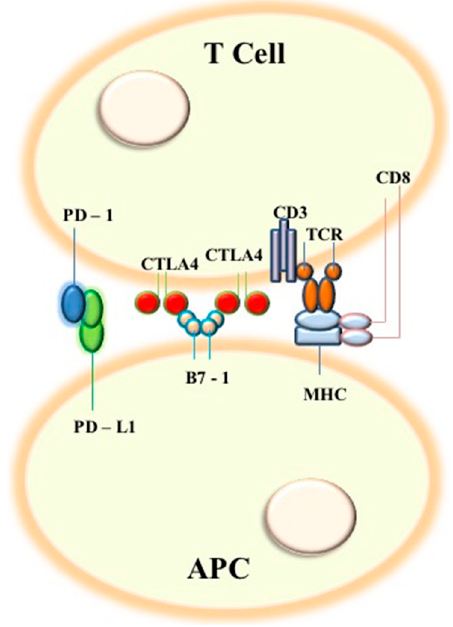
Figure 1. Schematic representation of principal interactions targeted by immune checkpoints inhibitors, including PD-1 (programmed cell death protein) and PD-L1 (programmed cell death ligand 1 protein), CTLA4 (cytotoxic T-lymphocyte antigen 4), B7-1, TCR and MHC (major histocompatibility complex) (with the co-function of CD3 and CD8 molecules) pathways, between T-lymphocytes (T cells) and antigen presenting cells (APCs). Table 1. Current and promising prognostic biomarkers in non-small cell lung cancer (NSCLC) treatment. Prognostic biomarker Current state of development FDA-approved and fully implemented PD-L1 expression in clinical practice Tumor mutational burden Under investigation Differential agretopicity index Under investigation STK11 mutations Under investigation High levels of tumor infiltrating lymphocytes (CD4+, Under investigation CD8+, CD8+/CD4+ ratio) Kynurenine/tryptophan ratios Under investigation Quinolinic acid concentrations Under investigation